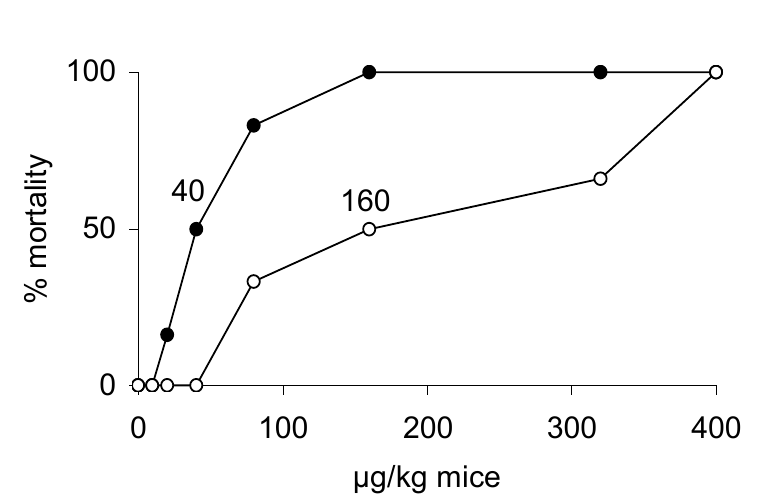
value of 40µg/kg mice, 50